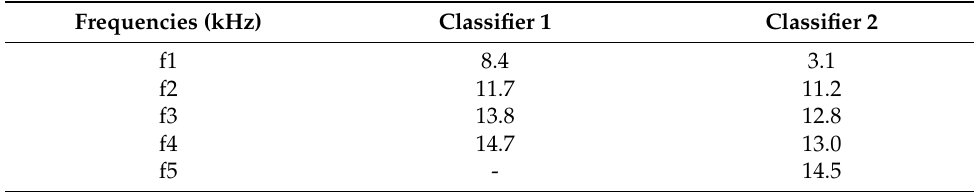
Table 4. Characteristics of the two classifiers provided by GGA+ELM to discriminate the fructose concentrations of Tables 1–3. The classifiers make a decision according to the value of aver-age energy density on specific frequencies in the acoustic response spectrum.